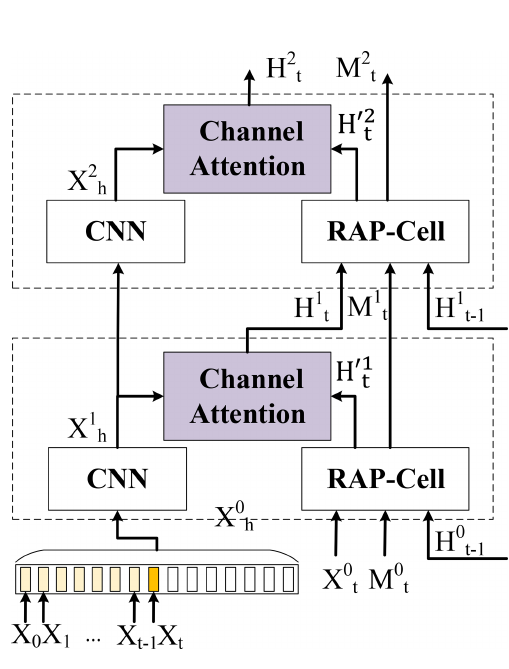
Figure 5. The manner of embedding the Recall Attention Mecha- nism (RAM) into the proposed predicted unit. Here, the RAP-Cell is the RAP unit without